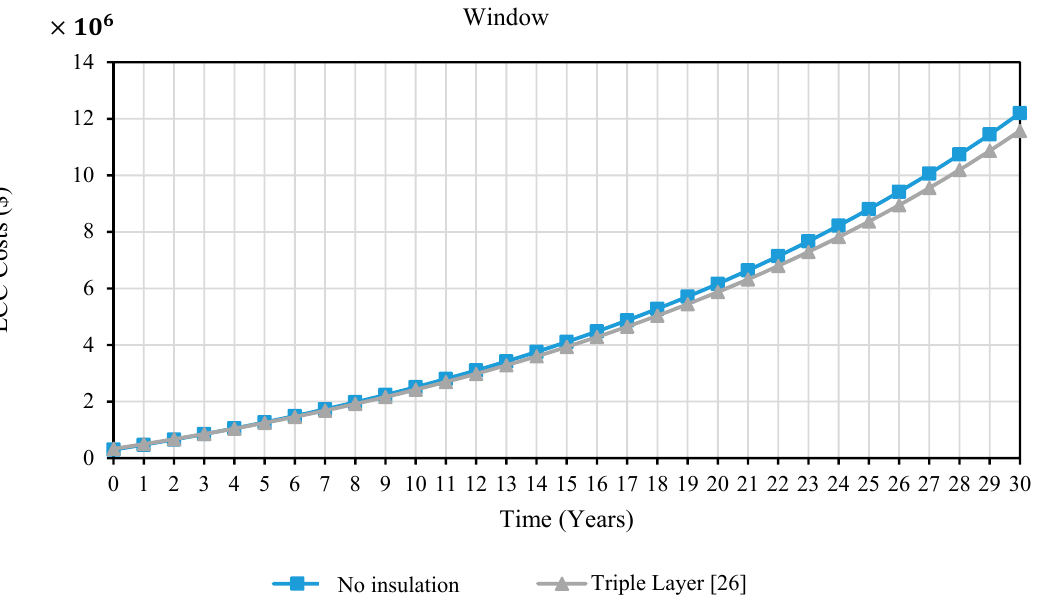
Figure 23. Comparison of the LCC for the windows with triple layer based on Table 5.